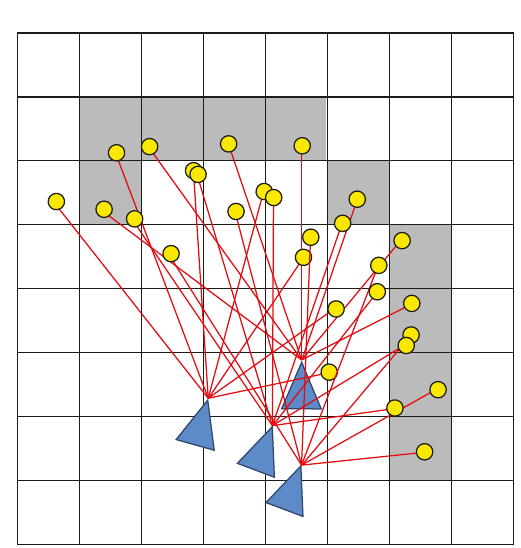
Figure 3: Matching particle swarms to grid